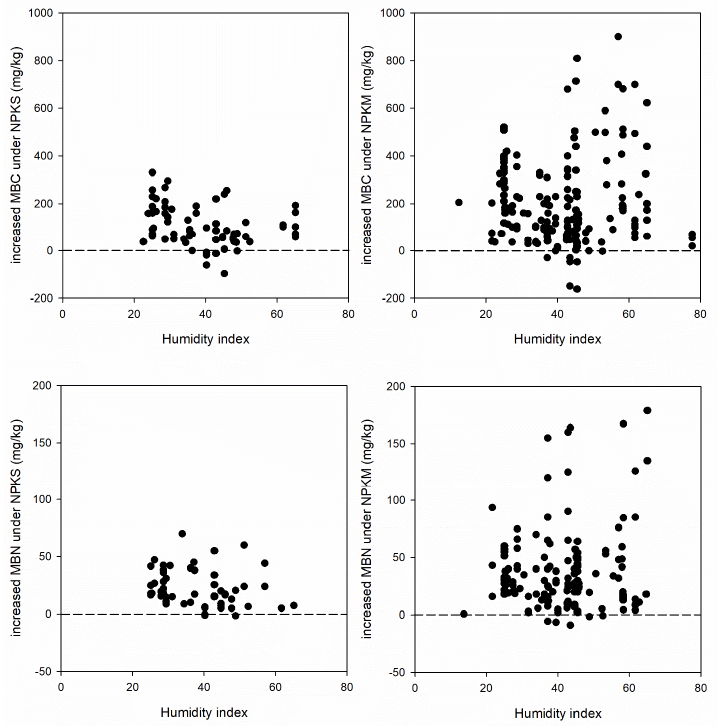
Figure 8. The relationships of MBC and MBN with HI (humidity index) under combined application of chemical and organic fertilizers, i.e., NPKS and NPKM. The dashed lines represent x = 0.